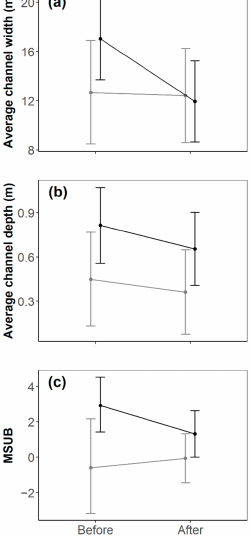
Figure 2. Statistical model outputs (mean and 95% confidence intervals) indicating the effects of restoration on hydromorphological properties. Control = grey; restored = black. Linear mixed-effect models were used to test ( a ) the average channel width and ( b ) the average channel depth, while a linear model was used to test ( c ) the mean substrate (MSUB).